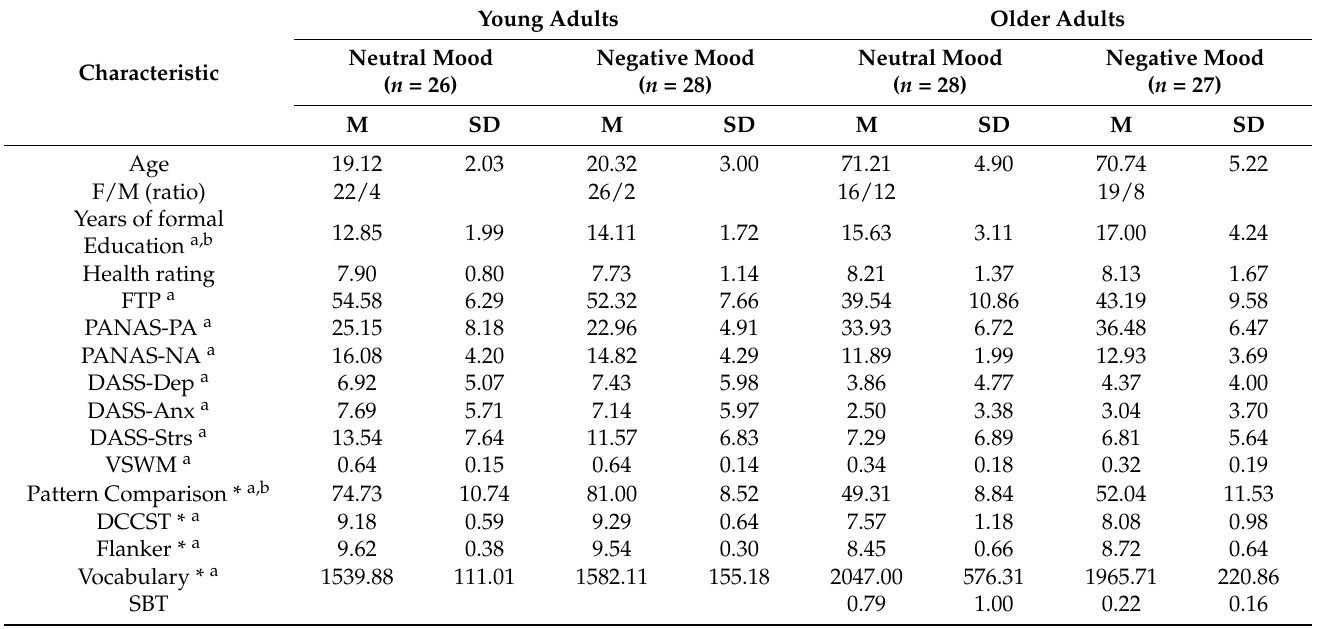
Table 1. Experiment 1 participant demographic characteristics and cognitive